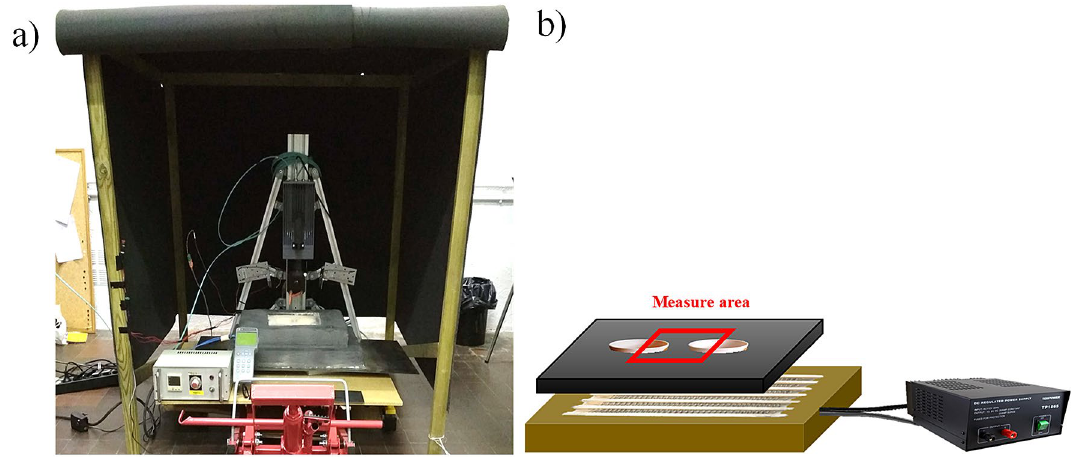
Figure 6. ( a ) Measurement system and ( b ) oven schematic representation and measurement